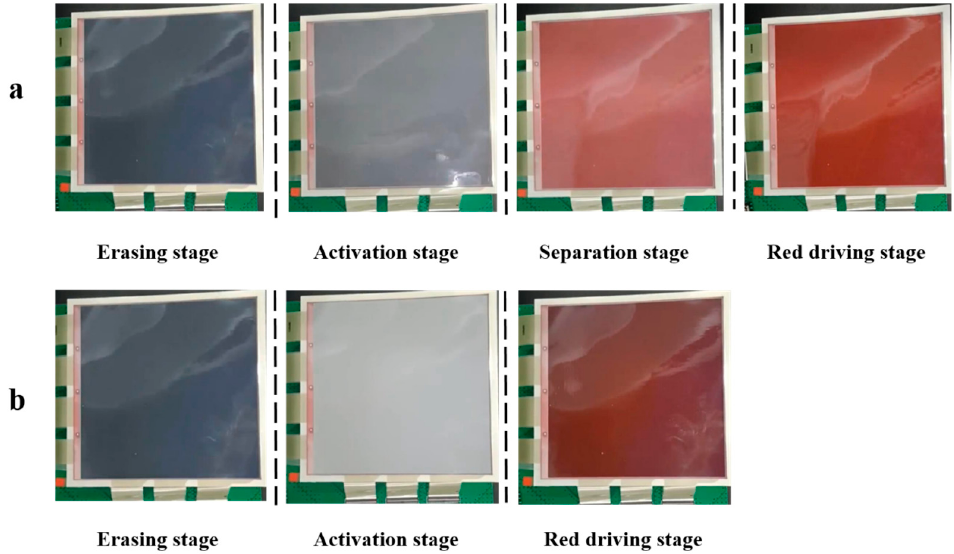
Figure 6. Images of the three-color EPD in each stage when it was driven by the two driving schemes. ( a ) It was driven by the proposed driving scheme. ( b ) It was driven by the traditional driving scheme.